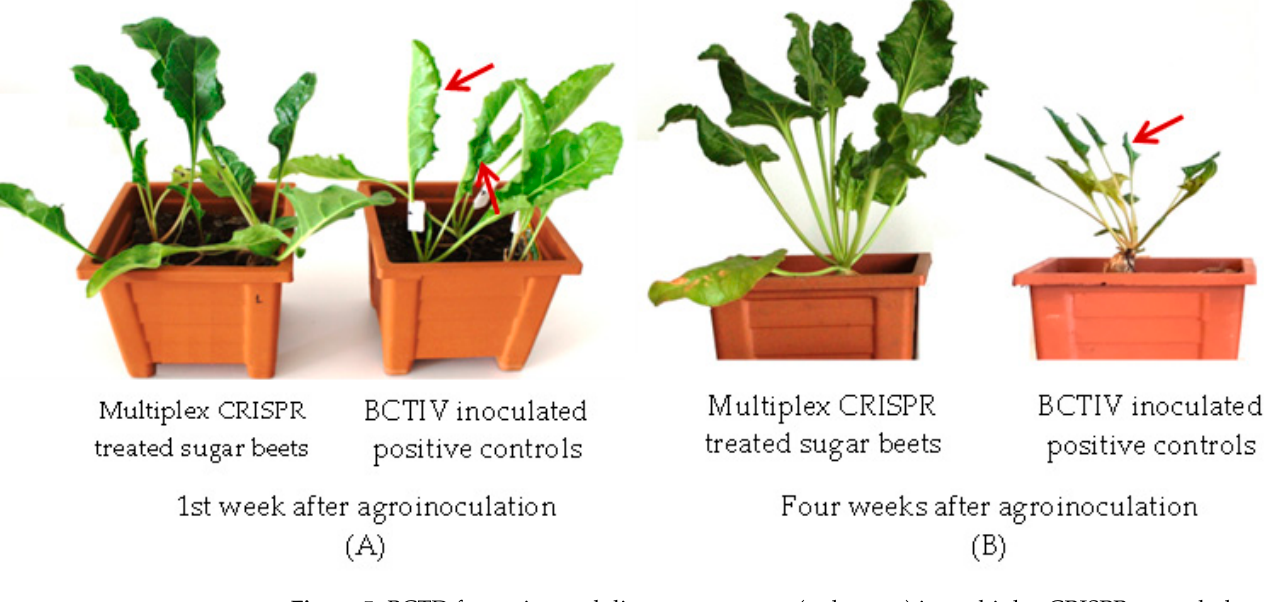
Figure 5 . BCTD formation and disease symptoms (red arrow) in multiplex CRISPR treated plants compared to only BCTIV inoculated control plants after first week of agroinoculation ( A ) and at the end of experiment ( B ).